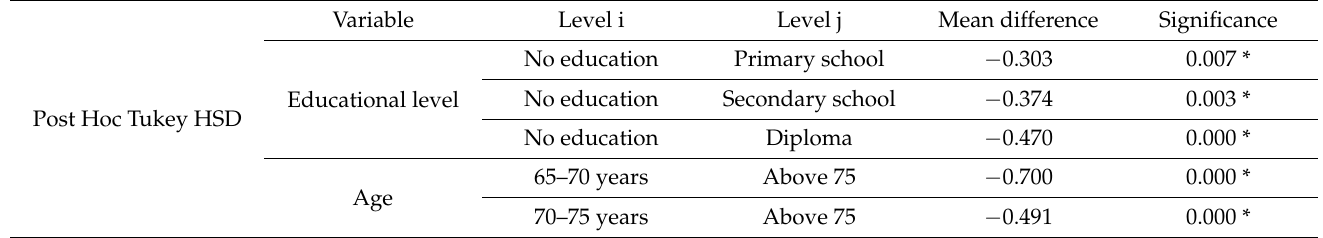
Table 5. Post Hoc Tukey HSD analysis for GSEOH scores according to educational levels and age factors.